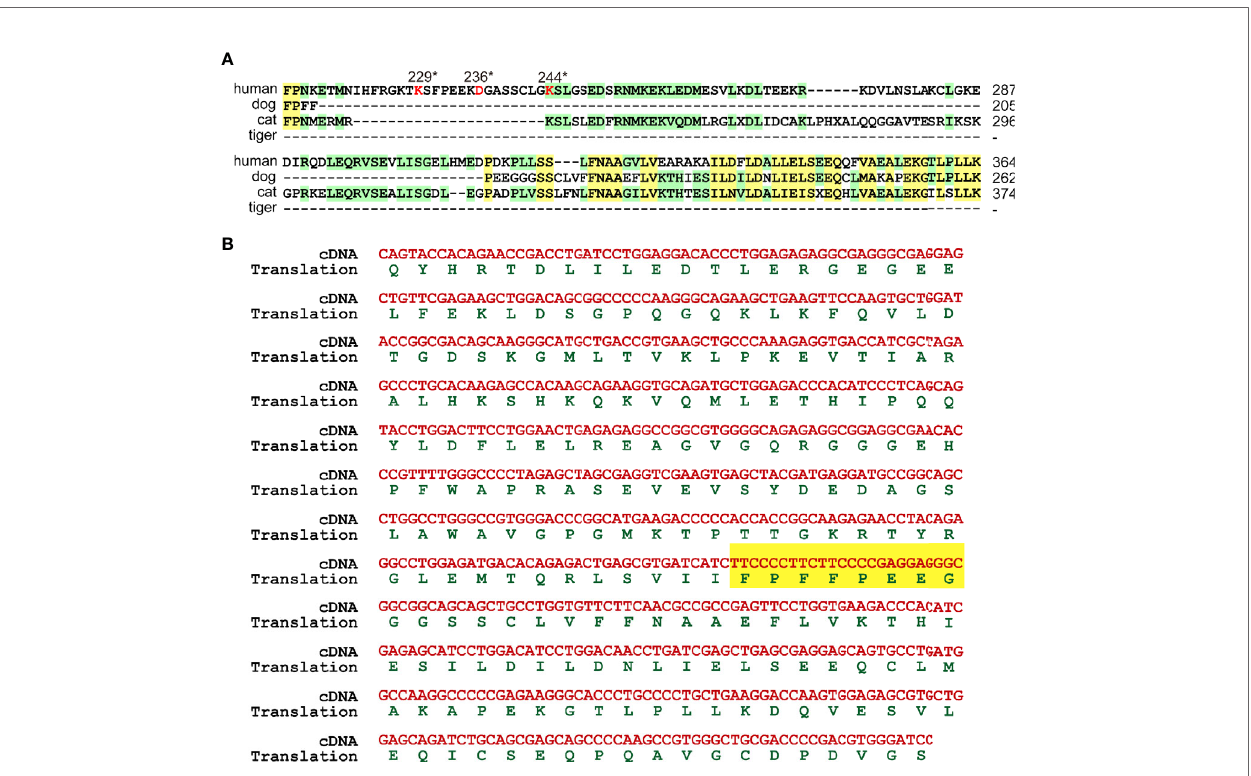
FIGURE 5 | GSDMB were de fi cient in cleavage sites. (A) GSDMB from dogs, cats and tigers lose the cleavage sites of CASP1 and granzyme (A) Protein sequences of GSDMB from humans, dogs, and tigers were aligned. The key cleavage sits are marked in red. (B) Sequence of dog GSDMB PCR ampli fi cation production and the deduced protein sequence were